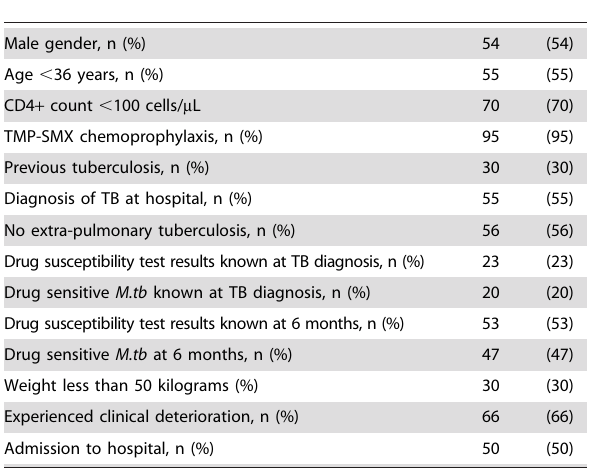
Table 1. Baseline characteristics and microbiologic confirmation of tuberculosis in 100 HIV-1 infected patients eligible for ART and receiving TB treatment.